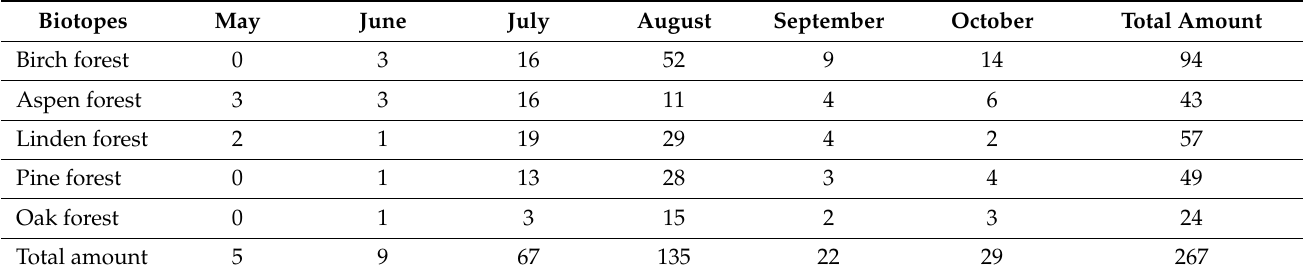
Table A6. Seasonal dynamics of Scaptodrosophila rufifrons in five biotopes.